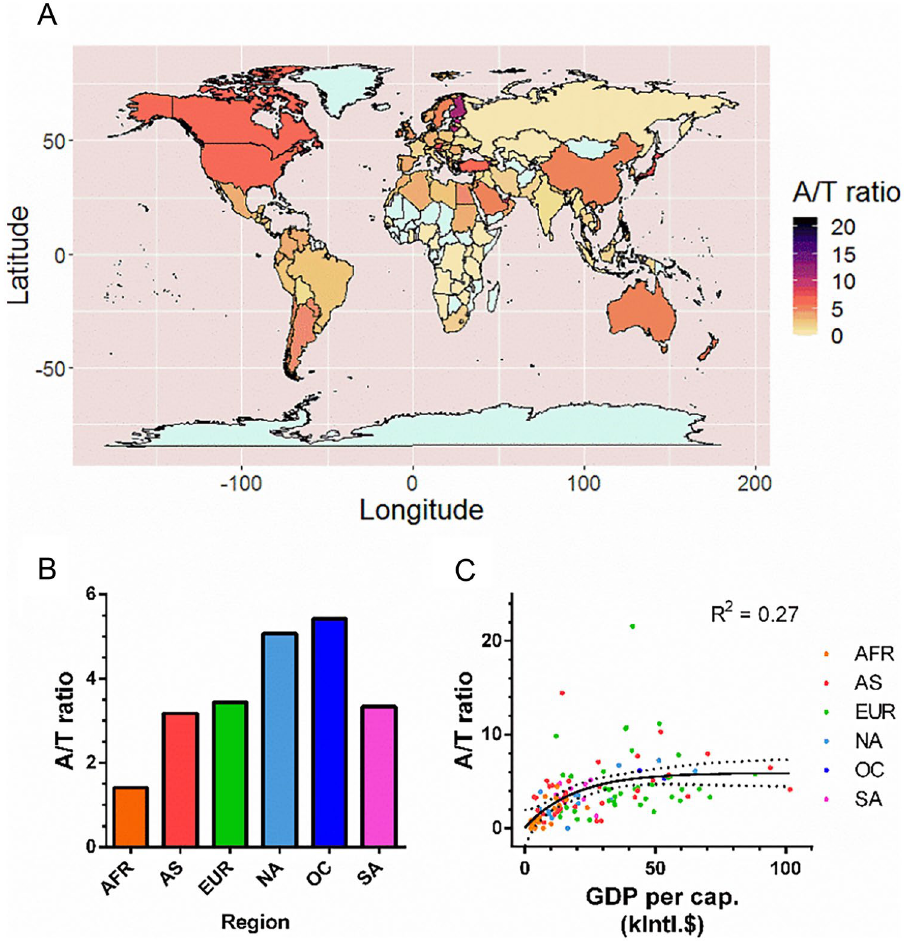
Figure 3. Worldwide atypical/typical antipsychotic drug (APD) search intensity (A/T) ratios and relation to gross domestic product (GDP). Data from 2020. In total, 122 countries with complete data were included. ( A ) Choropleth of A/T ratios per country. Light gray, data not available. ( B ) Comparison of population- weighted A/T ratios per continent. ( C ) A/T ratio as a function of GDP per capita (purchasing power parity). A monoexponential function was fitted to all data points (black; R 2 = 0.27), with 95% C.I. (dotted). AFR, Africa (n = 21); AS, Asia (n = 37); EUR, Europe (n = 37); NA, North America (n = 14); OC, Oceania (n = 2); SA, South America (n = 11). See Supplementary Table S5 for search intensity data. The choropleth graph was rendered using R, version 4.0.4, and the toolbox ggplot2 23